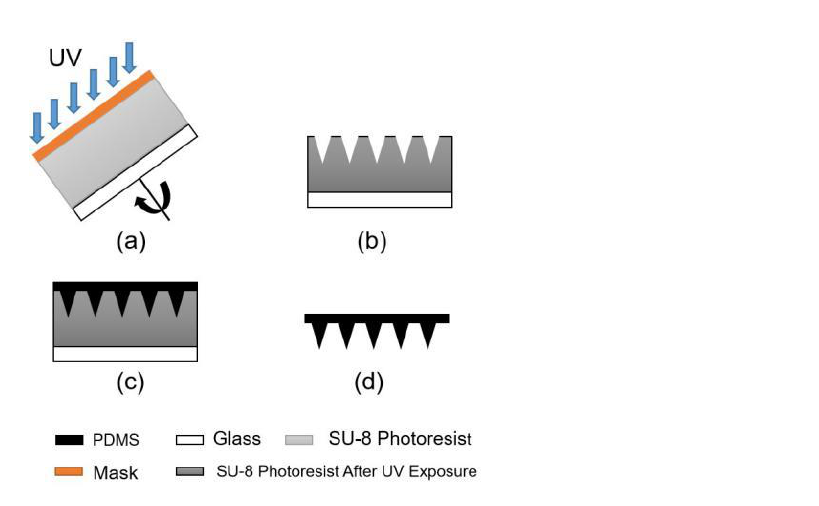
Figure 4. Manufacturing process of Conical MNA. ( a ) Tilting rotary exposure technology. ( b ) Conical array of concavities. ( c ) Polydimethylsiloxane (PDMS) transfer technology. ( d ) PDMS MNA.